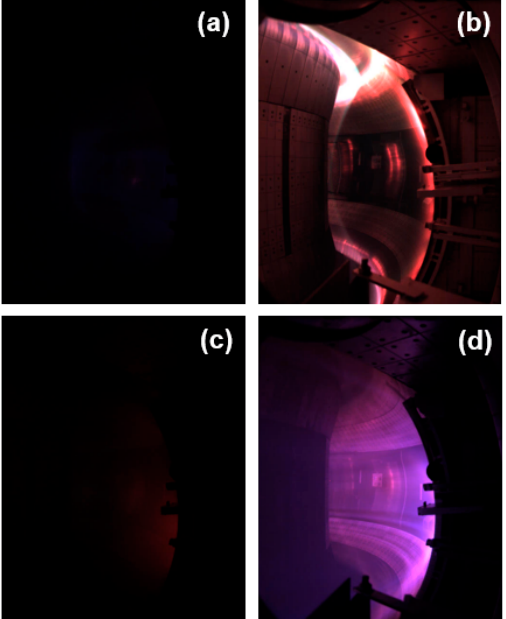
Figure 4. Image frames recorded by high ‐ speed CCD camera at ( a , c ) t = 0.08 s, and ( b , d ) t = 5.0 s in normal discharge (#84649) and recovery discharge (#84601), respectively.